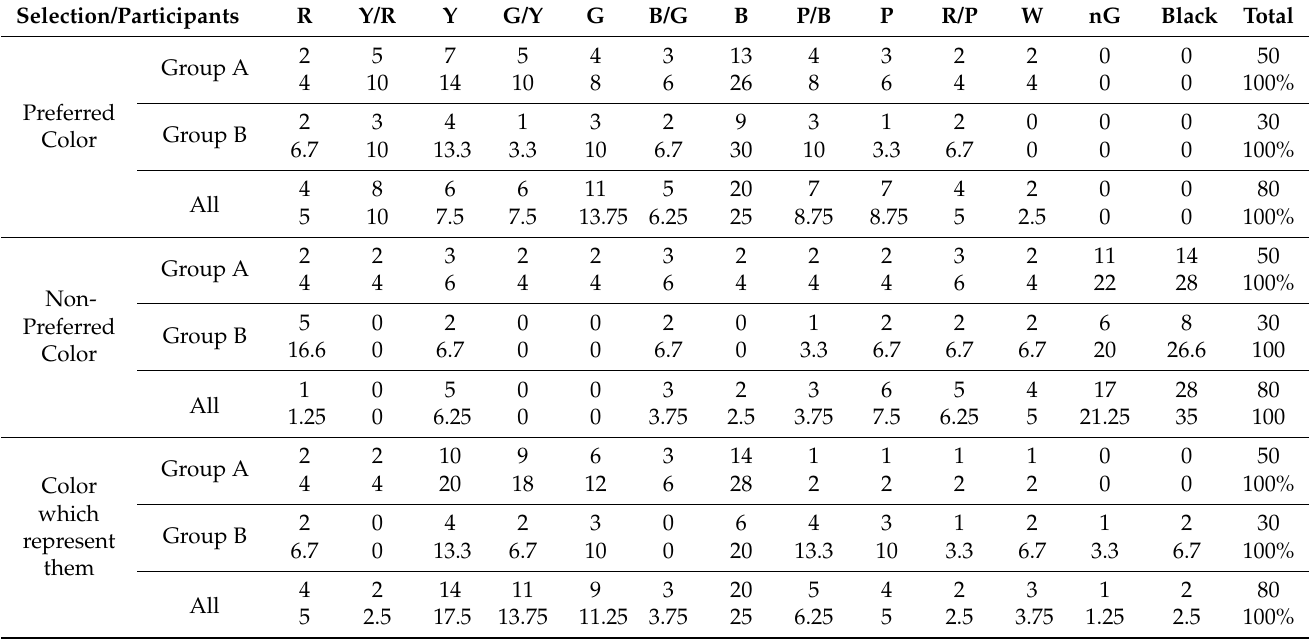
Table 2. Participants’ preferred color, non-preferred color, and representative